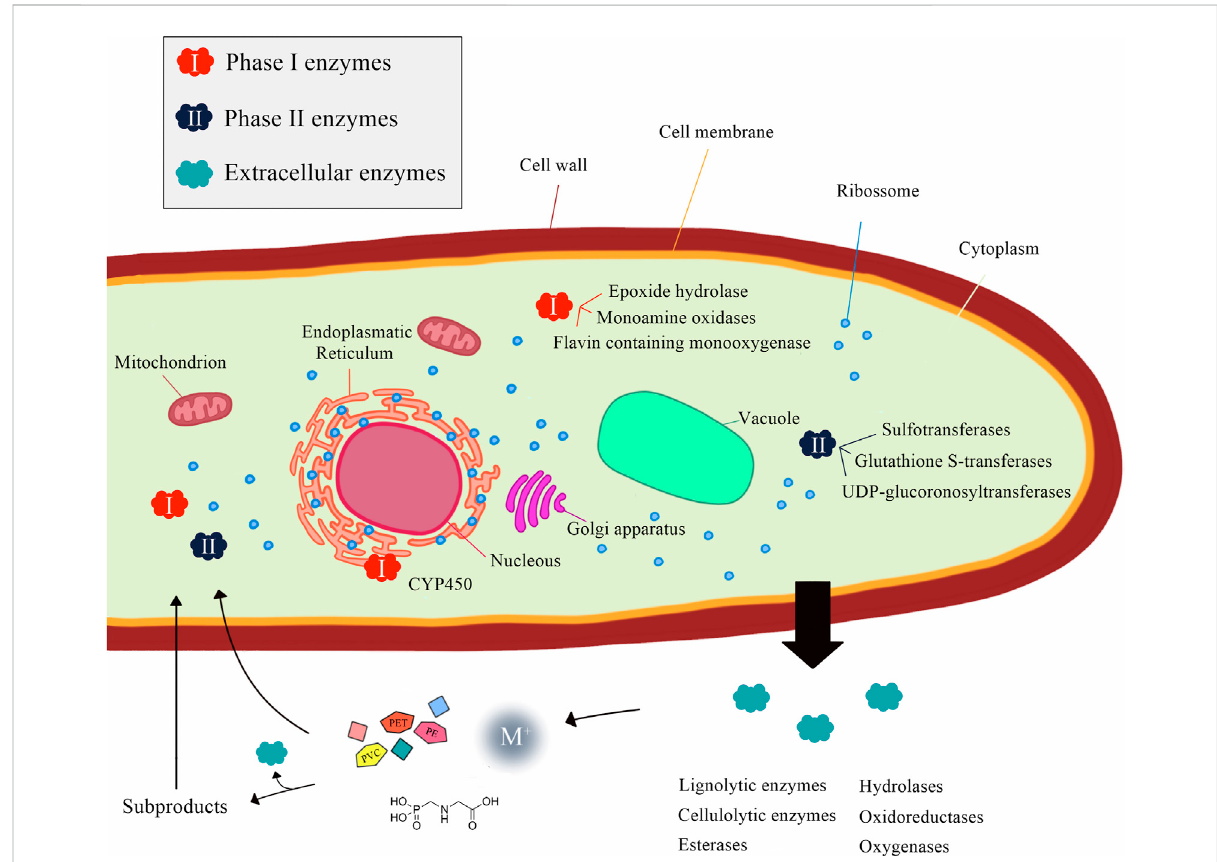
FIGURE 1 Intra- and extracellular enzymatic systems in fungi related to the biodegradation of environmental pollutants.